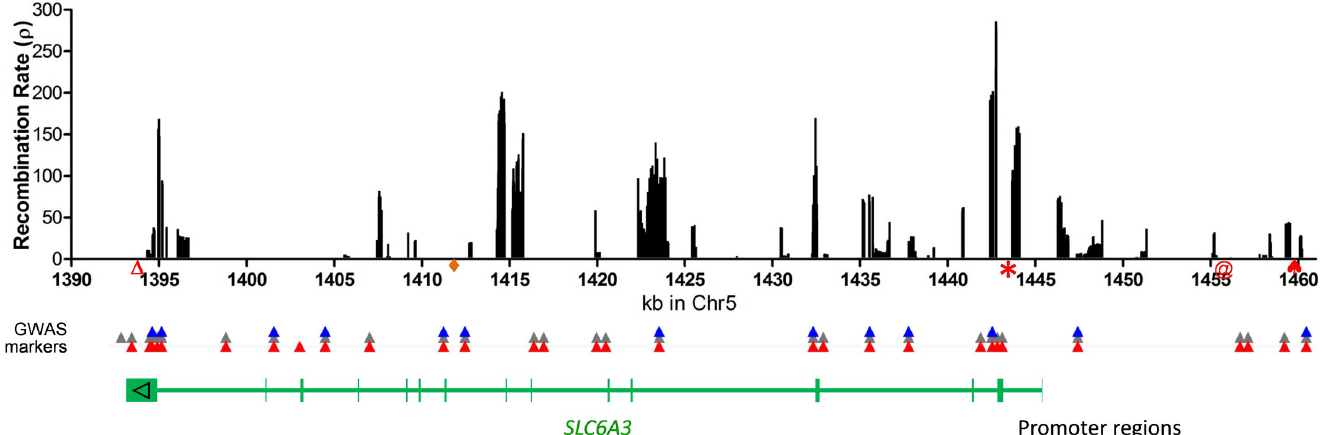
Fig 3. Caucasian recombination hotspots throughout SLC6A3 . Recombination rate was obtained from combined five European ancestry populations (CEU, TSI, FIN, GBR and IBS for a total of 505 subjects) whose genotype data were collected by the 1000 Genomes Project. Indicated are also two frequently used genotyping markers, 3’VNTR ( 4 ), Intron 8 VNTR ( ◆ ), DNPi ( � ), 5’VNTR (@), -14kb-VNTR ( ♠ ) and effective GWAS markers (red ▲ for COGA, gray for SAGE and blue for the Australian twin-family study all from dbGaP; “effective” means surviving after the data quality control). Below the GWAS markers is SLC6A3 gene structure in green (vertical bars are 15 exons in the opposite strand of the chromosome), localizing the polymorphisms and mostly intronic recombination hotspots in the gene. Six populations of African ancestry in the 1KGP (African Caribbean’s in Barbados (ACB), Americans in SW USA (ASW), Luhya in Webuye of Kenya (LWK), Esan (ESN) and Yoruba in Ibadan (YRI) of Nigeria, and Mende in Sierra Leone (MSL)) all carried the main hotspots at 1395, 1415, and 1443 (details not shown).